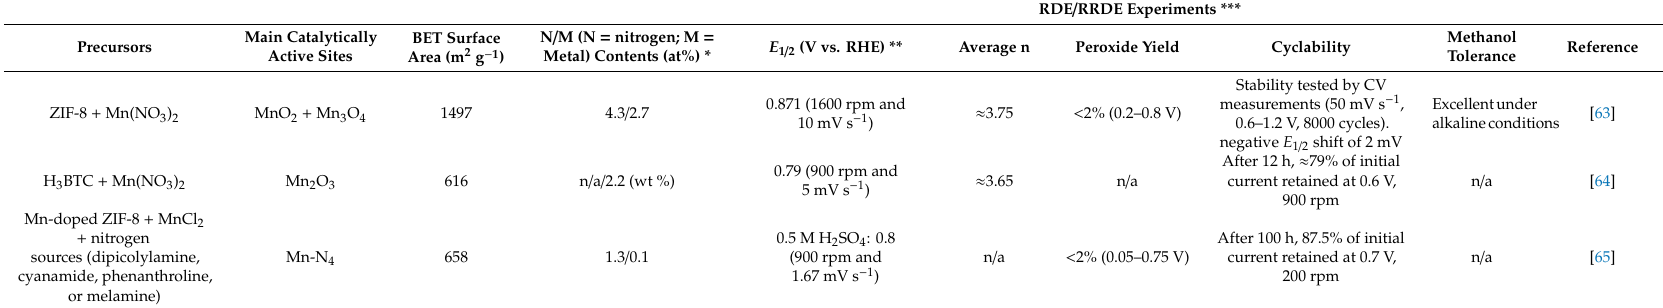
Table 2. Recent research works (2018–2020) dealing with the preparation of Mn-based electrocatalysts for fuel cells with a focus on ORR activity. Examples in acidic and alkaline media are provided, and major physicochemical properties and electrochemical performances realized using rotating electrodes are